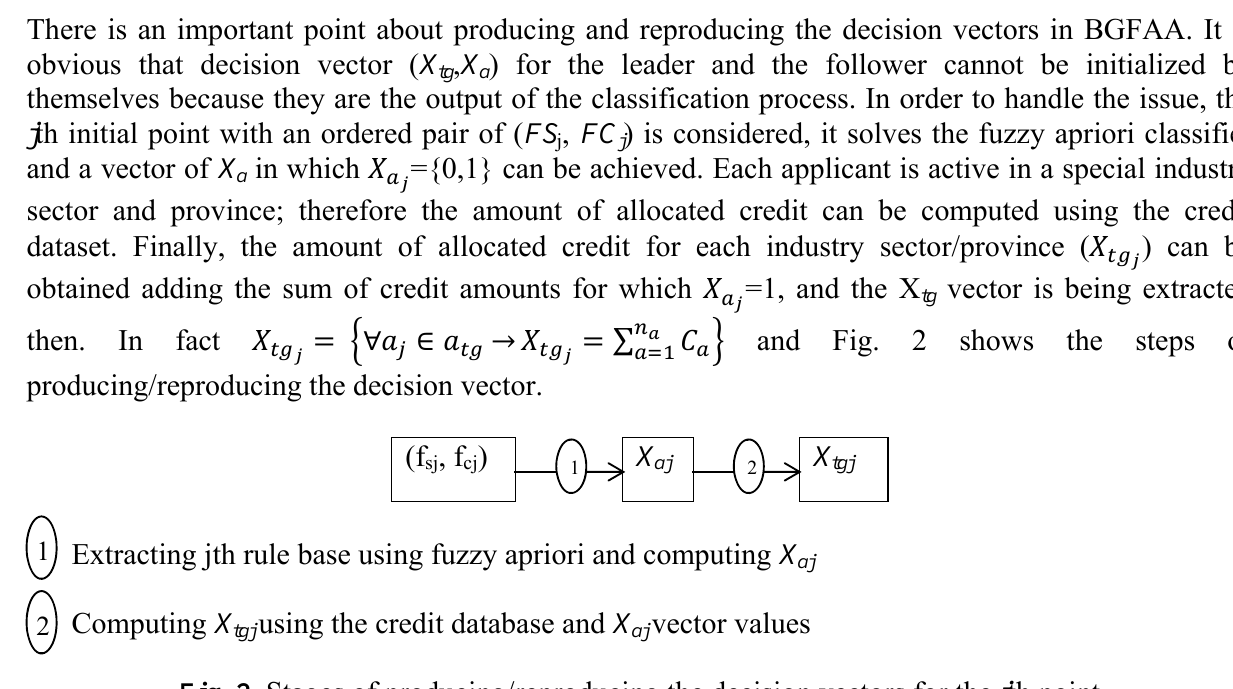
Fig. 2. Stages of producing/reproducing the decision vectors for the j th